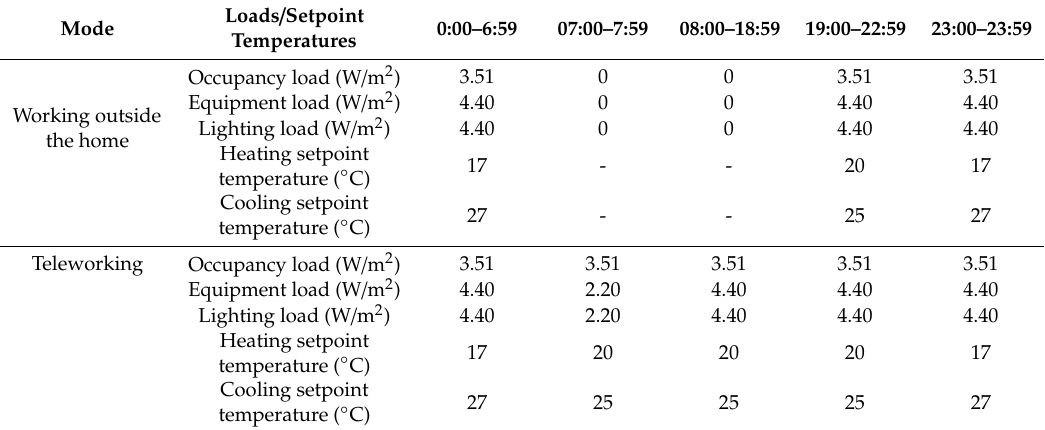
Figure 5. Model of the case study in DesignBuilder. Table 5. Operational profiles.